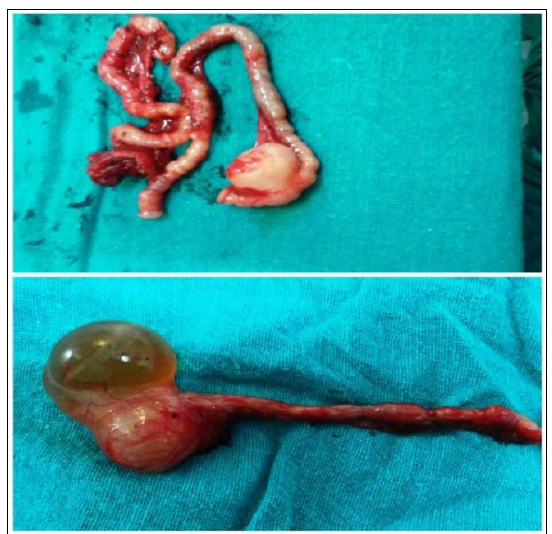
Figure 3: Resected ileal duplication cysts with atretic ileal segments.